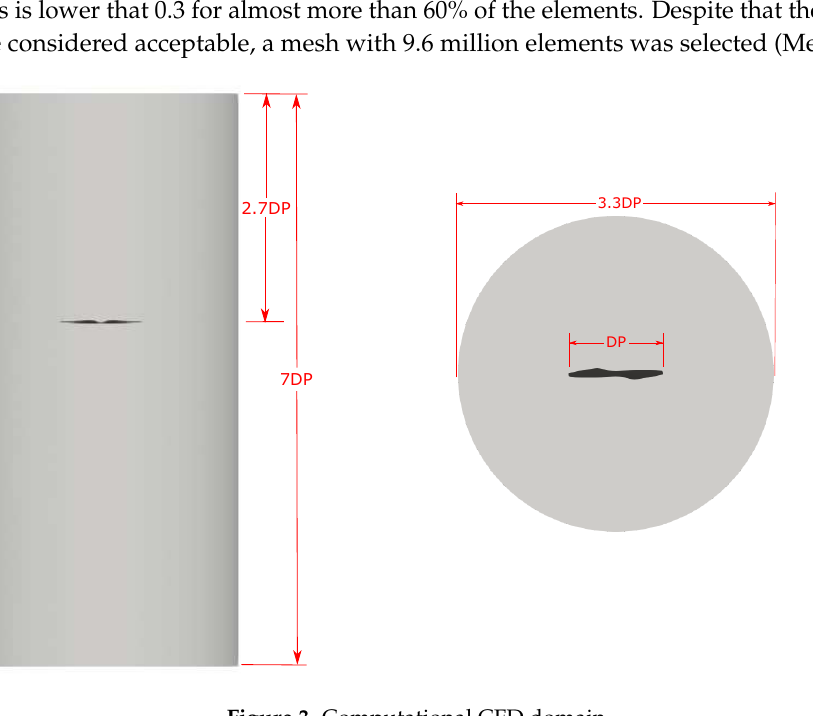
Figure 3. Computational CFD domain.